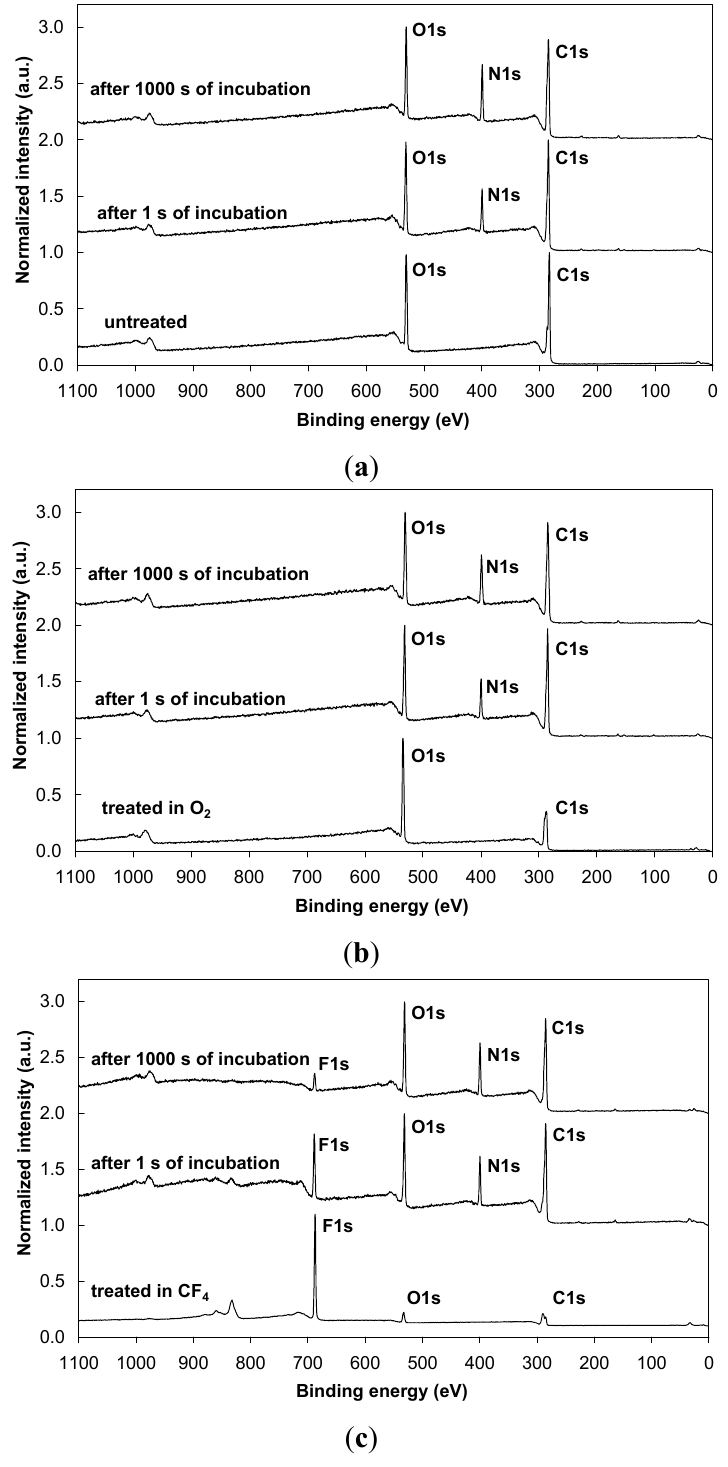
Figure 3. XPS survey spectrum for: ( a ) the control (untreated) PET sample before and after incubation for 1 s and 1,000 s; ( b ) the PET sample treated in O after incubation for 1 s and 1,000 s and ( c ) the PET sample treated in CF and after incubation for 1 s and 1,000 s in albumin